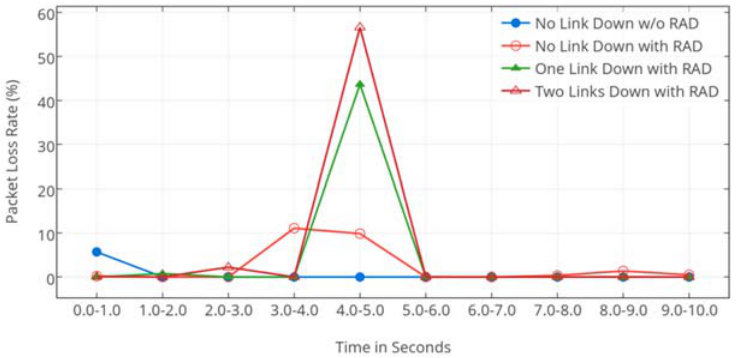
Figure 3. Packet loss rate (%) vs. time.